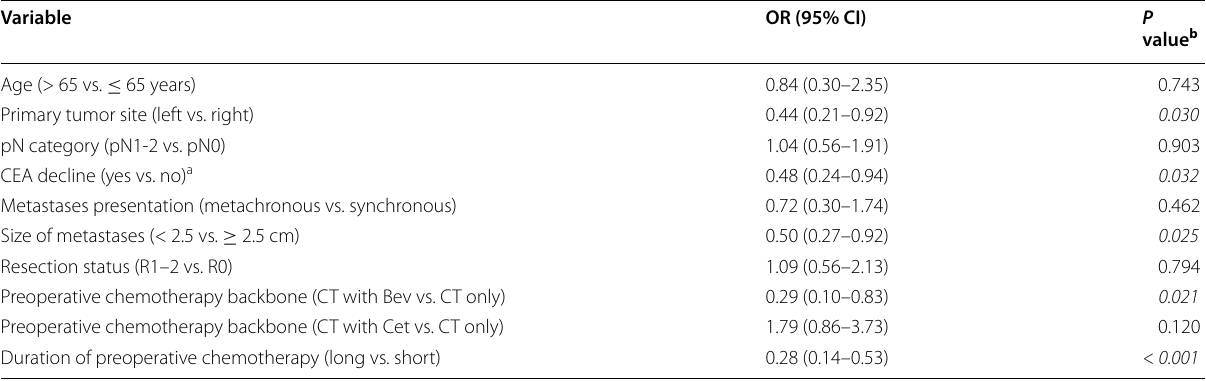
Table 4 Multivariable logistic analyses of potential benefit factors for pathologic response in terms of tumor-related analysis